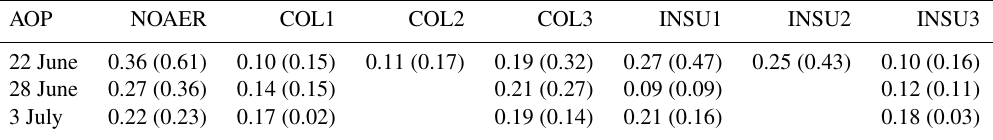
Table 6. Comparison of the measured and modelled CLIMAT BTs. Model calculations are made with different AOPs. Differences are expressed as RMSD (K) from data at three different altitudes and for the three CLIMAT channels (see text). The RMSD at the maximum altitude is shown in